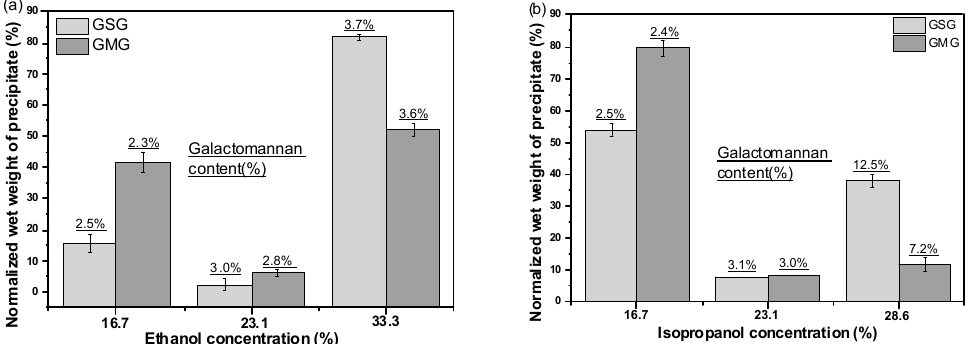
Figure 3. Normalized wet mass ratio and galactomannan concentration of the gum fractions of GSG and GMG obtained from ( a ) ethanol and ( b ) isopropanol precipitation.